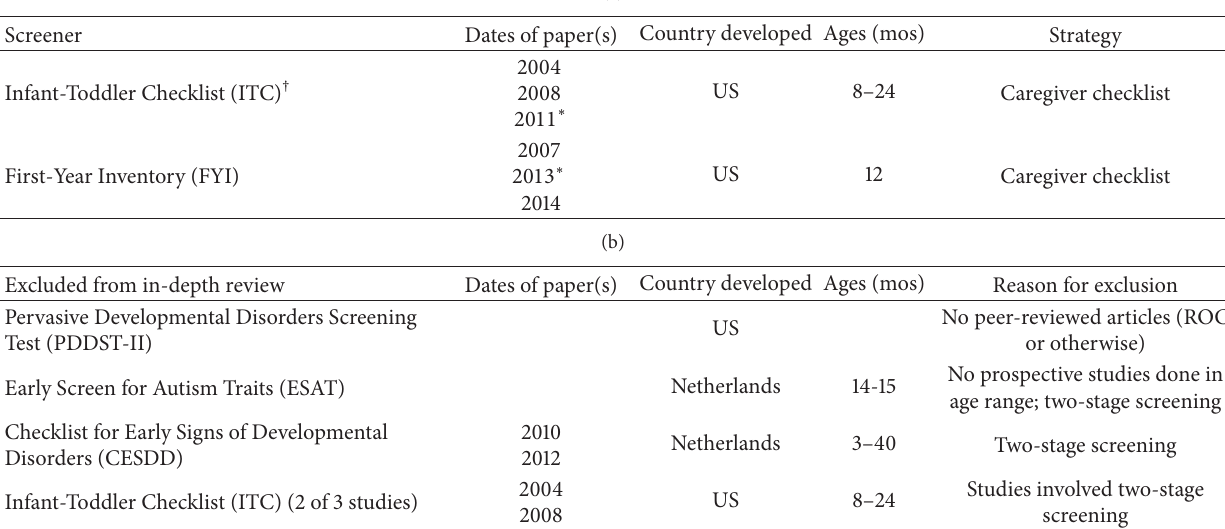
Table 2: Level 1 ASD screening instruments